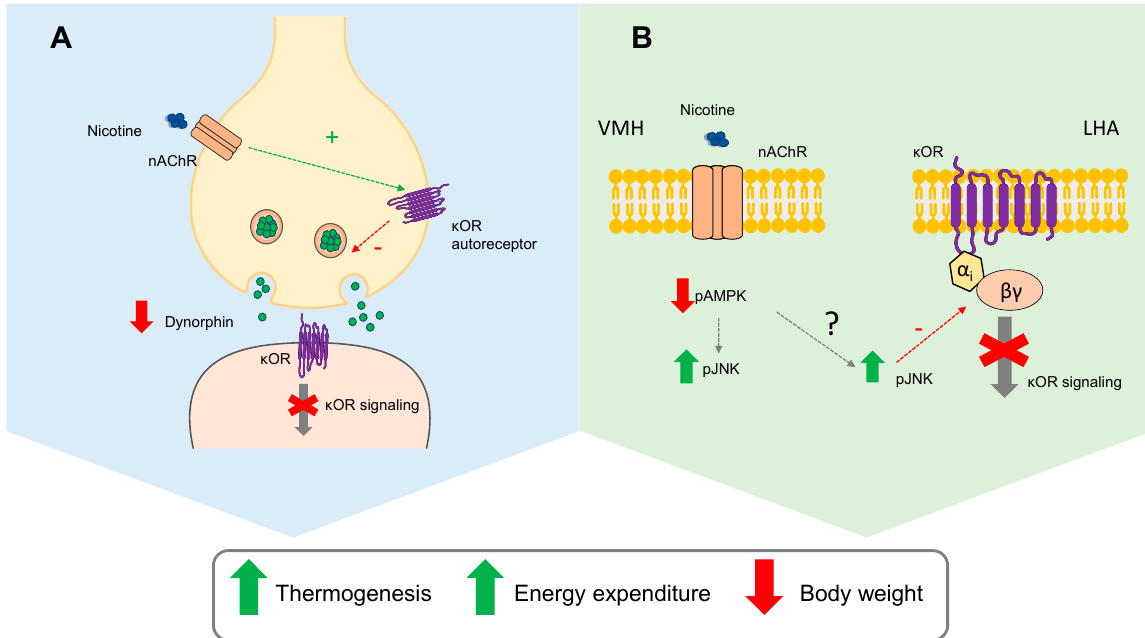
Figure 5. κ OR in the LHA as a mediator of nicotine actions on energy balance. Nicotine-induced activation of thermogenesis and the consequent increase in energy expenditure and decreased body weight could be explained by two models involving κ OR. ( A ) Nicotine signaling by an unknown mechanism would activate κ OR auto-receptors at the presynaptic level, leading to an inhibitory feedback of the release of dynorphin peptides, thus reducing postsynaptical κ OR signaling. ( B ) Nicotine activates hypothalamic JNK, which, by a mechanism involving structural changes in the κ OR signaling complex, would inhibit κ OR downstream effectors. The mechanism by which nicotine increases JNK in the LHA is unknown but could be mediated by changes in AMPK, in response to nicotine treatment. AMPK, AMP-activated protein kinase; JNK, c-Jun N-terminal kinase; κ OR, Kappa opioid receptor; LHA, lateral hypothalamic area; nAChR, nicotinic acetylcholine receptor; VMH, ventromedial hypothalamic nucleus.